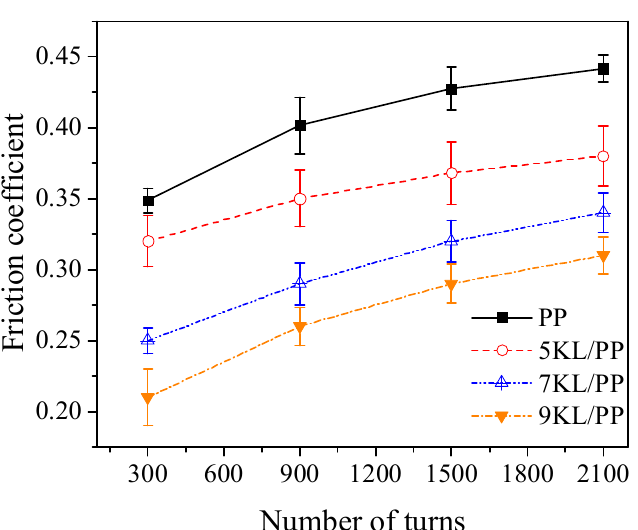
Figure 6. Relationship between the friction coefficient and numbers of turns and kaolin content of kaolin/PP composites.